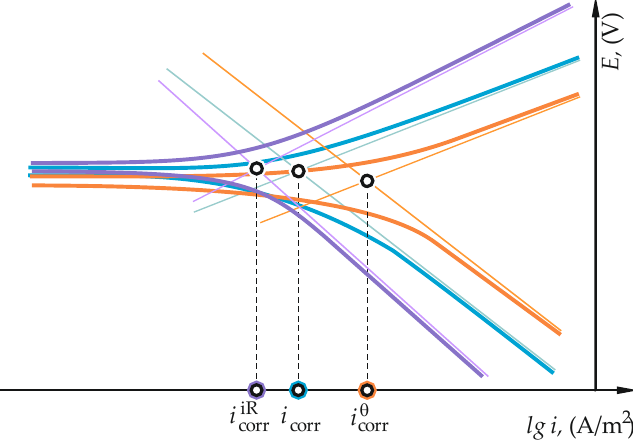
Figure 15. The impact of changed moisture content of concrete and uncompensated drop of potential across concrete cover on the shape of polarization curves and on determined values of corrosion current density — description in the text.